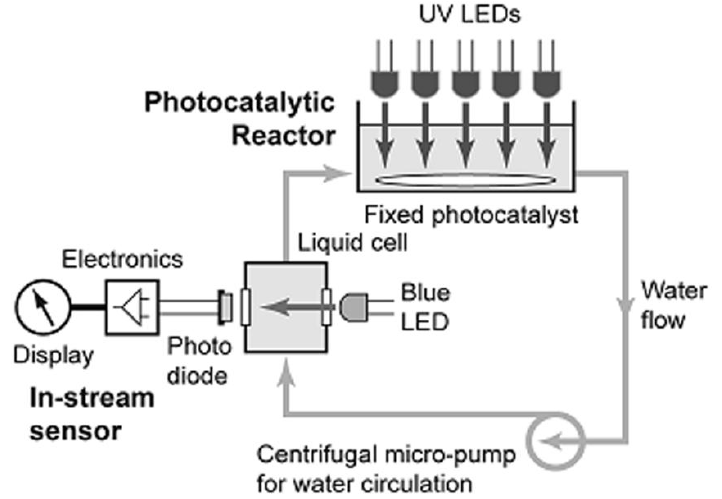
Figure 3. Schematic of the UV-LED-based photocatalytic reactor equipped with a real time in-stream sensor unit (Adapted with permission from [104]. Copyright (2012) American Chemical